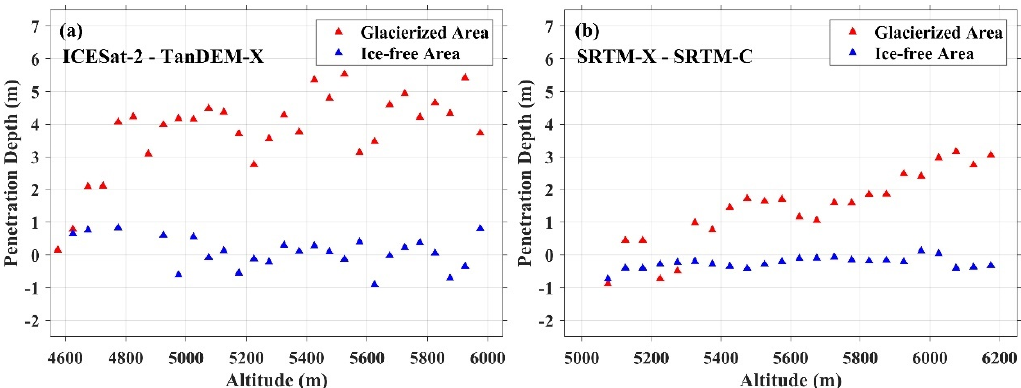
Figure 7. Distribution of measured radar penetration depths against altitude: ( a ) X-band penetration depth measured by differencing ICESat-2/ATLAS ATL06 elevations and TanDEM-X elevations. ( b ) Difference between X-band and C-band penetration depths measured by differencing SRTM-X and SRTM-C DEM.